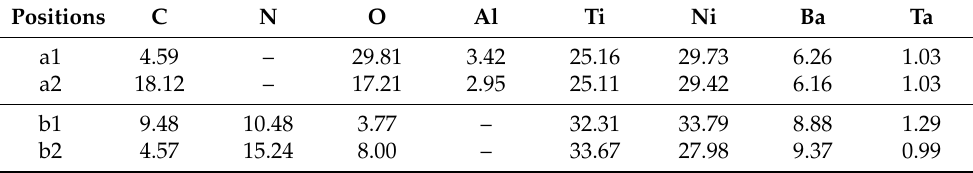
Figure 8. The SEM worn scar images of NiTi alloy, ( a ) untreated (sample S-1), and ( b ) laser nitriding with the laser a scanning speed of 40 mm/s and frequency of 200 kHz at room temperature (sample S-3). Table 3. The EDX elemental analysis in the worn scars of the NiTi alloy (marked in Figure 8, At%).